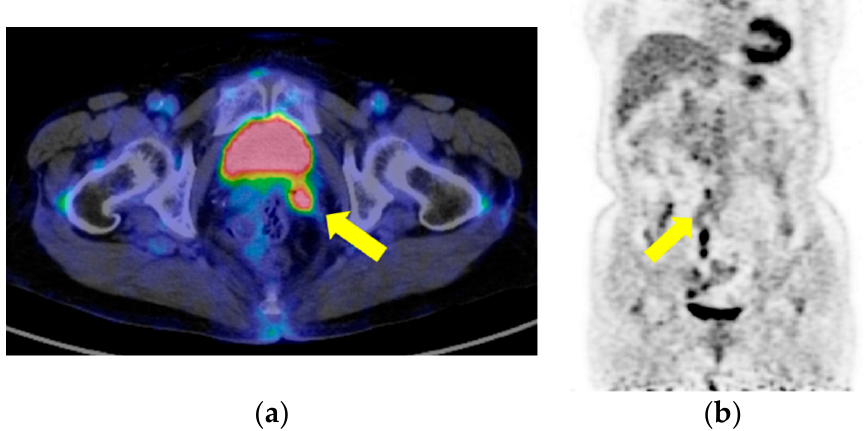
Figure 3. Positron emission tomography showing recurrence lesions in the ( a ) vaginal stump and ( b ) para-aortic lymph node. Yellow arrow point to the disease lesion.